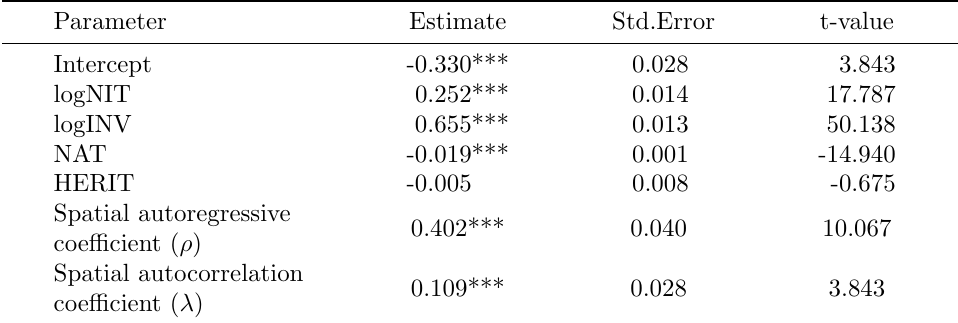
Table 3: Parameter estimates of the spatial lag and spatial error model with fixed effects